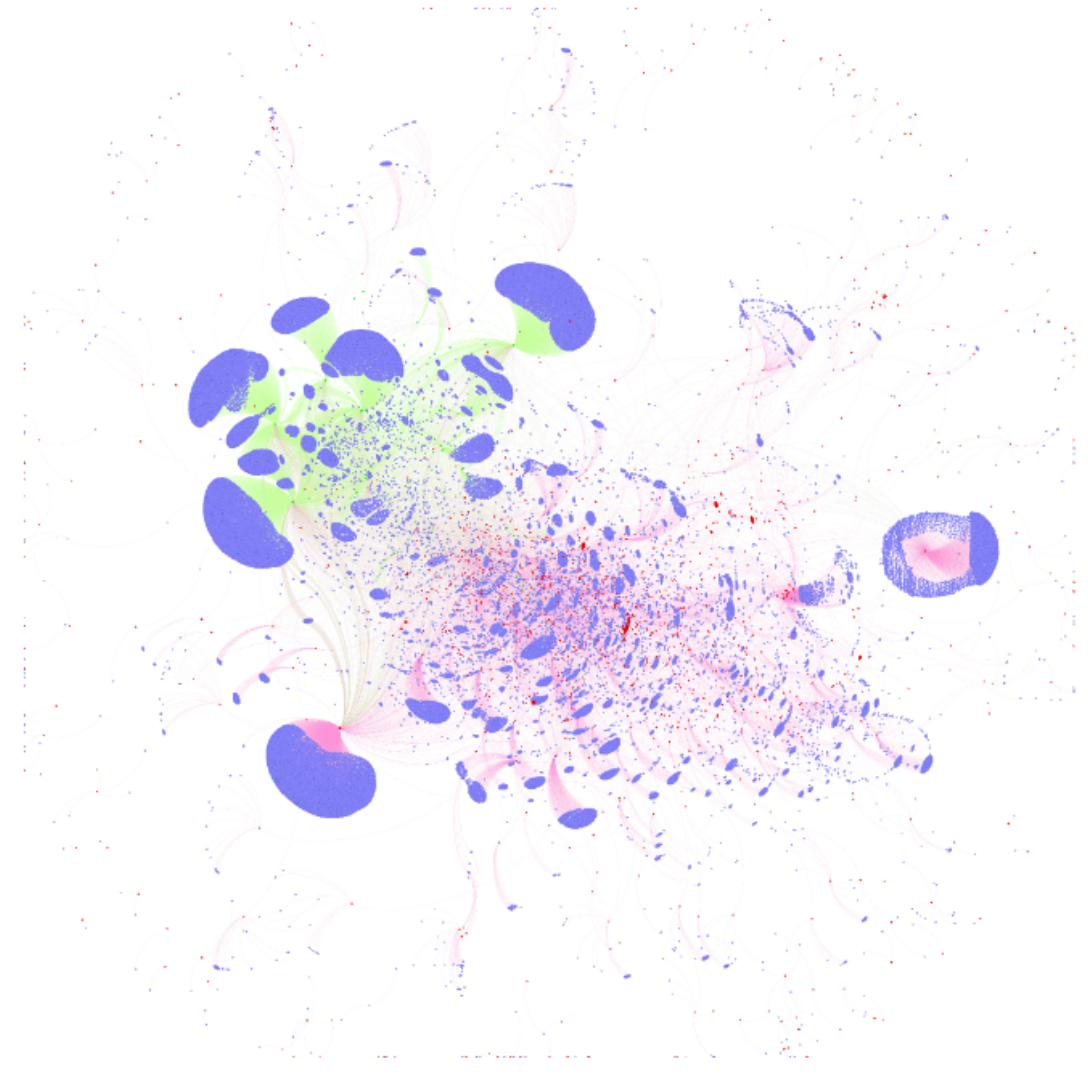
Figure 2. Relationship among referral websites and LOPs and IOPs based on real data.The pink nodes are the IOPs, the green nodes are the LOPs and the blue nodes are their referral websites. LOPs: legitimate online pharmacies; IOPs: illicit online